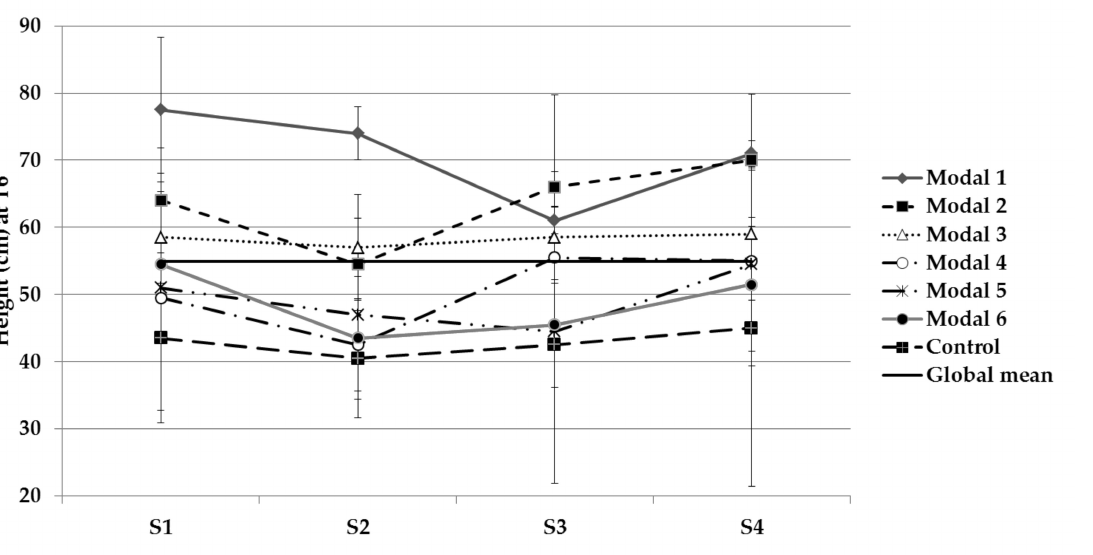
Figure 6. Graph of means of stem length (on the vertical axis) for each modality tested according to the different substrates (on the horizontal axis), 6 weeks after planting. S1 = 100% coconut fiber; S2 = 66% coconut fiber + 33% bagasse; S3 = 50% coconut fiber + 50% bagasse; S4 = 33% coconut fiber + 66% bagasse). Modality 1 = AMF (strain IP21); modality 2 = AMF (strain IP21) + Trichoderma harzianum ; modality 3 = AMF (strain IP21) + Pseudomonas fluorescens (strain IPB04); modality 4 = AMF (strain IP21) + Trichoderma harzianum + Pseudomonas fluorescens (strain IPB04); modality 5 = commercial AMF product containing 6 AMF strains; modality 6 = commercial AMF product containing 6 AMF strains + Trichoderma harzianum. Confidence level was 95%.